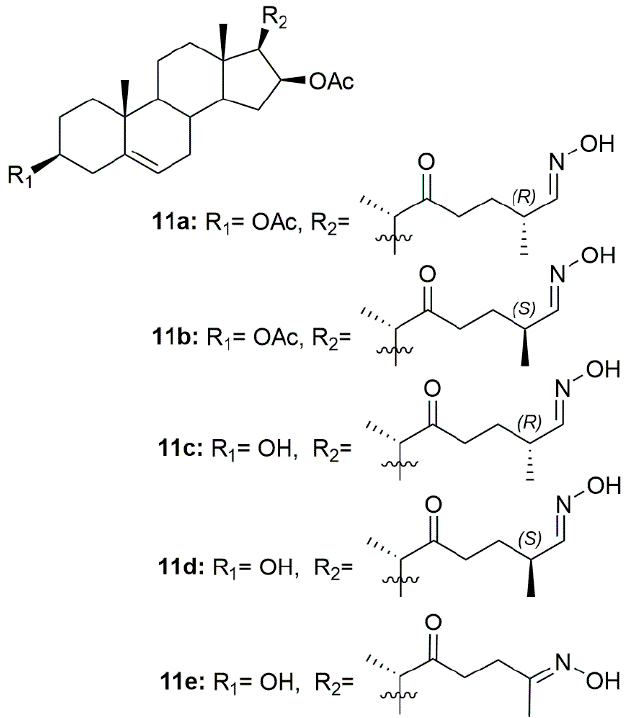
Figure 14. Cholestane oxime derivatives with anti-inflammatory activity.